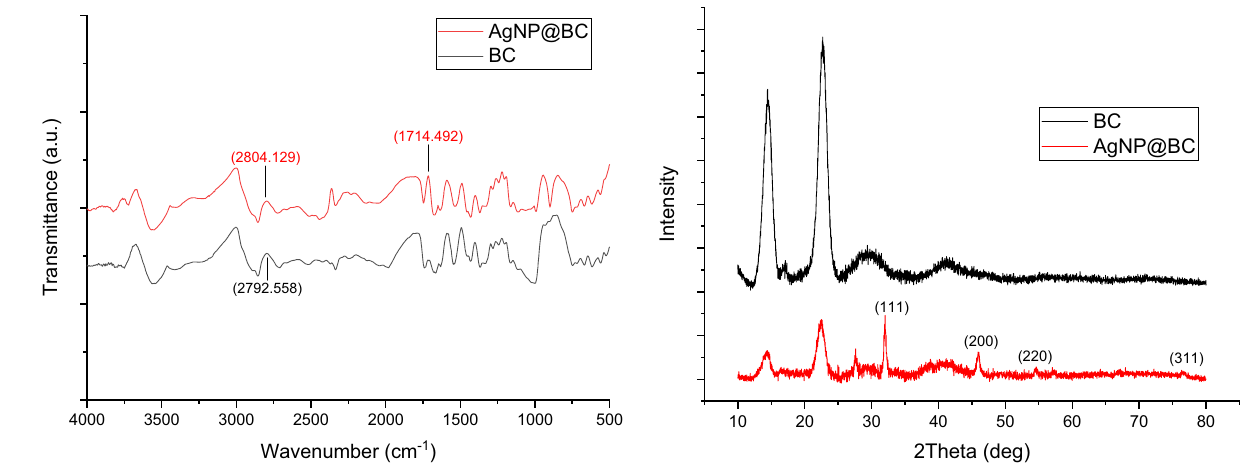
Figure 3: FTIR spectra of pristine BC and sample AgNP10@BC. Figure 4: XRD graph of pristine BC and